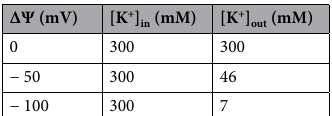
Table 3. Demanded ΔΨ equilibrium potentials and corresponding calculated [K +